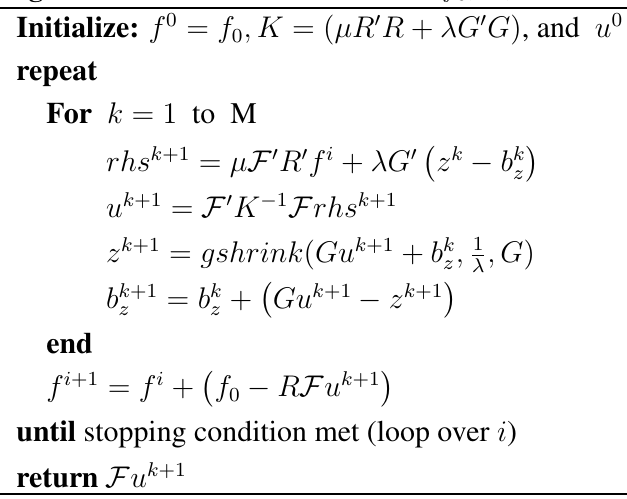
Algorithm 1: SBGS Reconstruction f